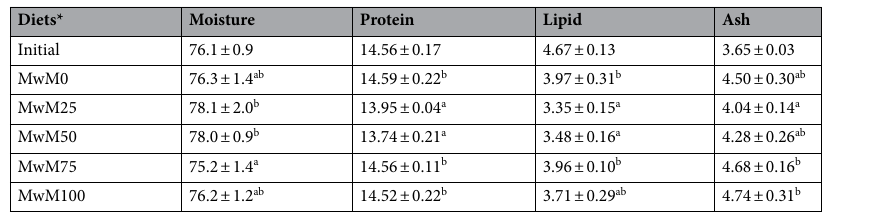
Table 5. Whole body composition (% wet weight) of tilapia fed with increasing dietary levels of mealworms. Values are the mean ± S.E. of triplicate groups of fish. Mean values within the same column with the different superscripts are significantly different ( P < 0.05). *See Table 2 footnote for diet